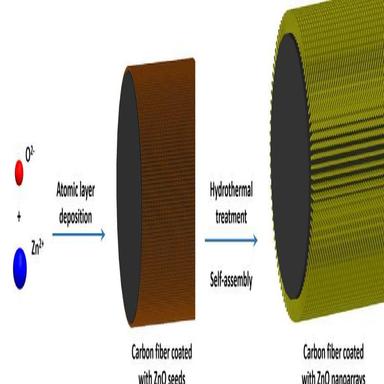
Schematic of synthesis procedure of hybrid structural fibers using combined ALD and hydrothermal methods.